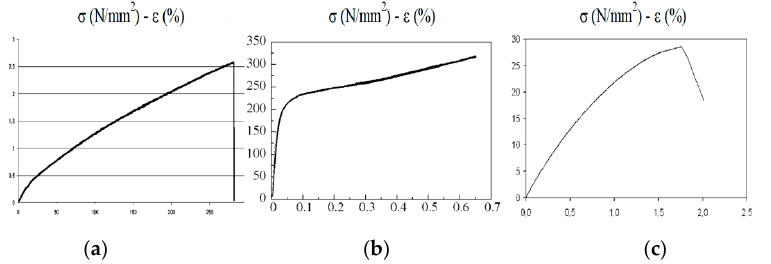
Figure 8. σ - ε diagrams of different types of adhesives in tension; ( a ) silicone [1], ( b ) acrylate [18], ( c ) epoxy [1].